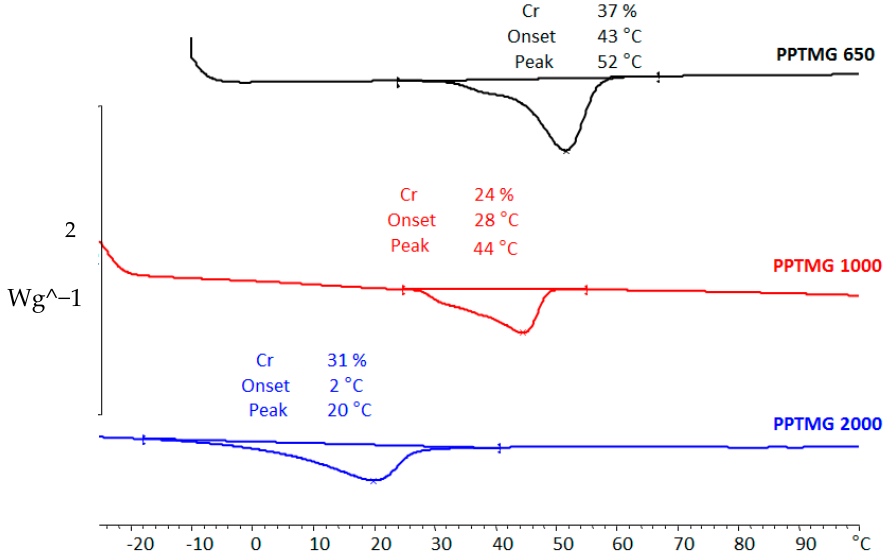
Figure 4. DSC curves of PTUR polymers based on PTMG segments of different molecular weight.